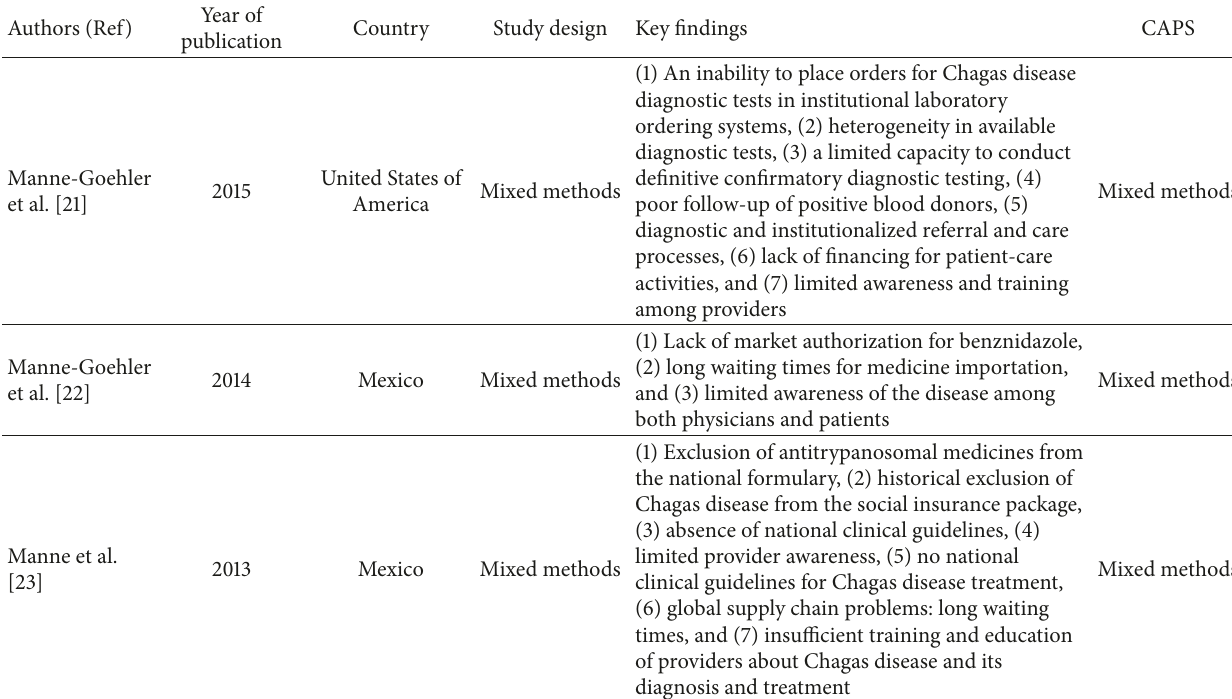
Table 1: Main characteristics and study design of the articles included in this